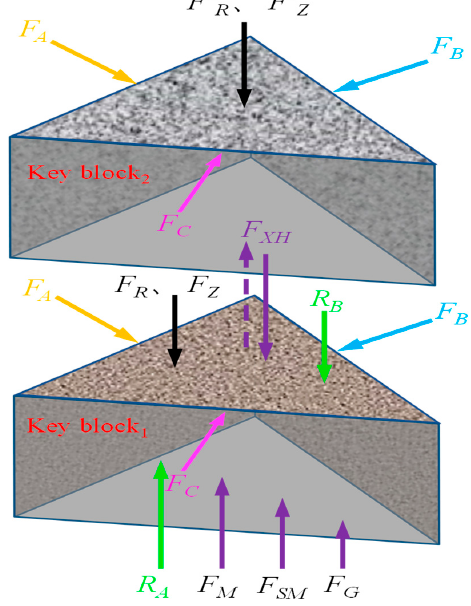
Figure 7. Mechanical analysis of the key triangular plate structure [47]. (3)